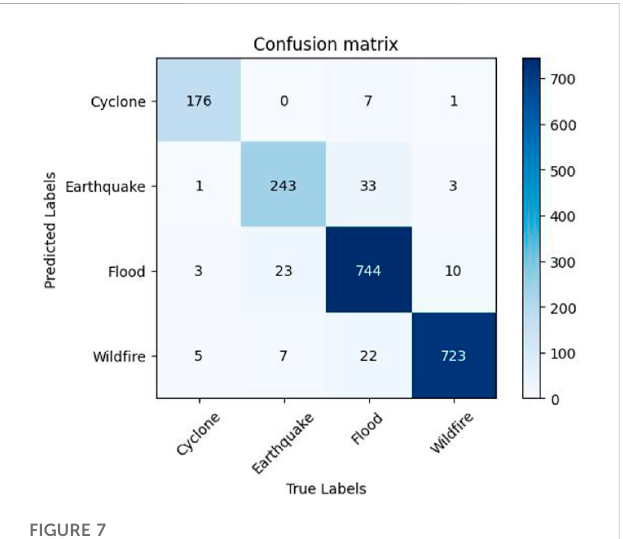
FIGURE 7 D-Net algorithm confusion matrix diagram.